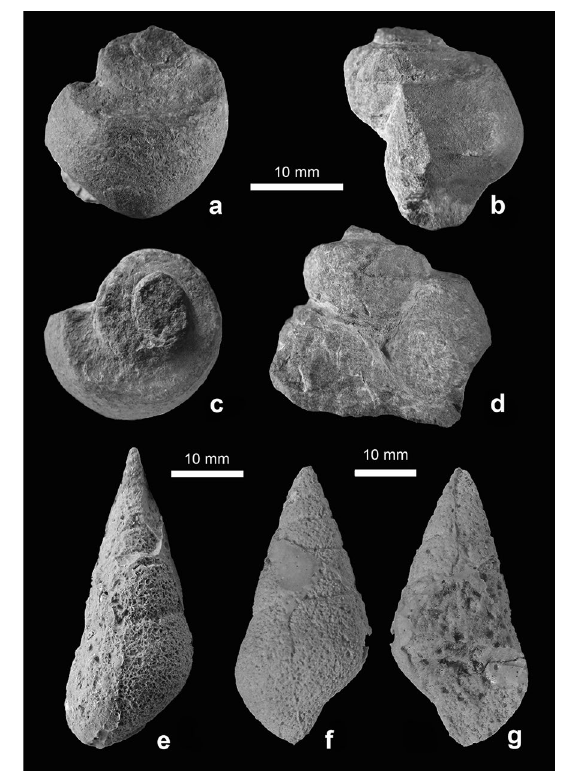
Fig. 4 a – d ? Trachynerita sp., Middle Besano Formation, uppermost Anisian. PIMUZ 37303: a apical side view, b side, c apical, and d apertural view. e ? Omphaloptycha sp. 1, Lower Besano Formation, uppermost Anisian. PIMUZ 37312: Abapertural view. f , g ? Omphaloptycha sp. 2, Lower Besano Formation, uppermost Anisian. PIMUZ 29951: f abapertural and g apertural view. Images a – d have been obtained from original specimen; images e – g from silicon